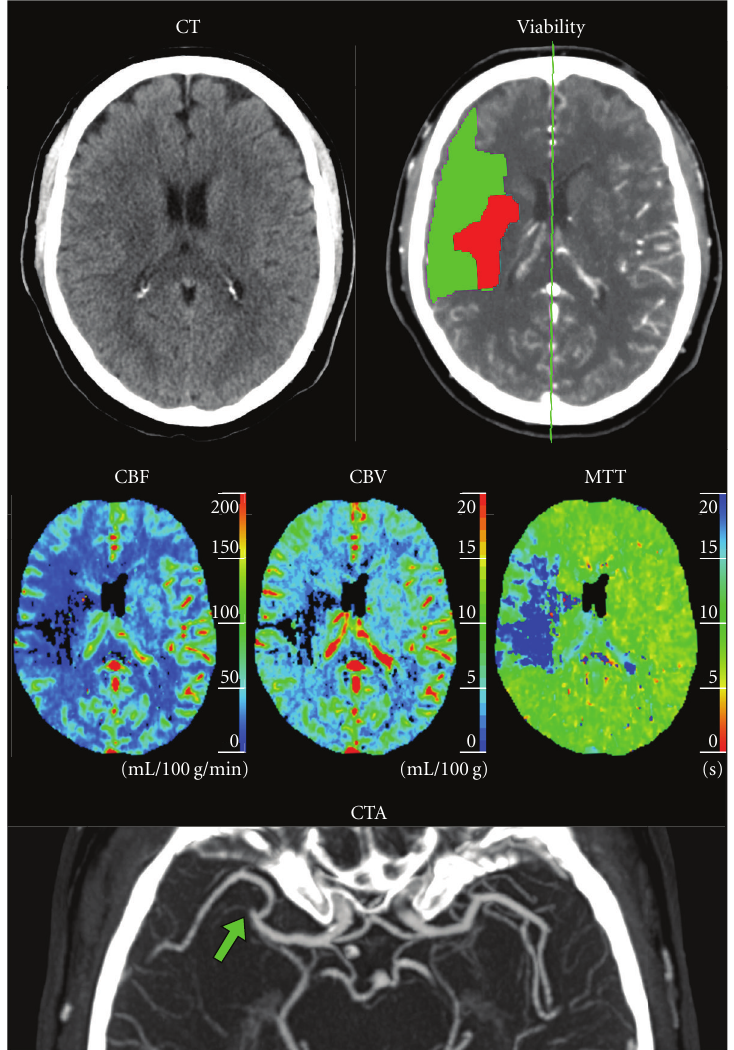
Figure 1: Case 1: 66-year-old male with left-sided stroke symptomsand a normalNECT. Initial comprehensive examination showsreduction of both CBF and CBV in the right hemisphere and an increase in MTT caused by a right-sided M2-segment MCA occlusion (arrow) seen on the CTA. The CTP viability map shows a small area of advanced perfusion defect (red) in the right hemisphere surrounded by a relatively large penumbra